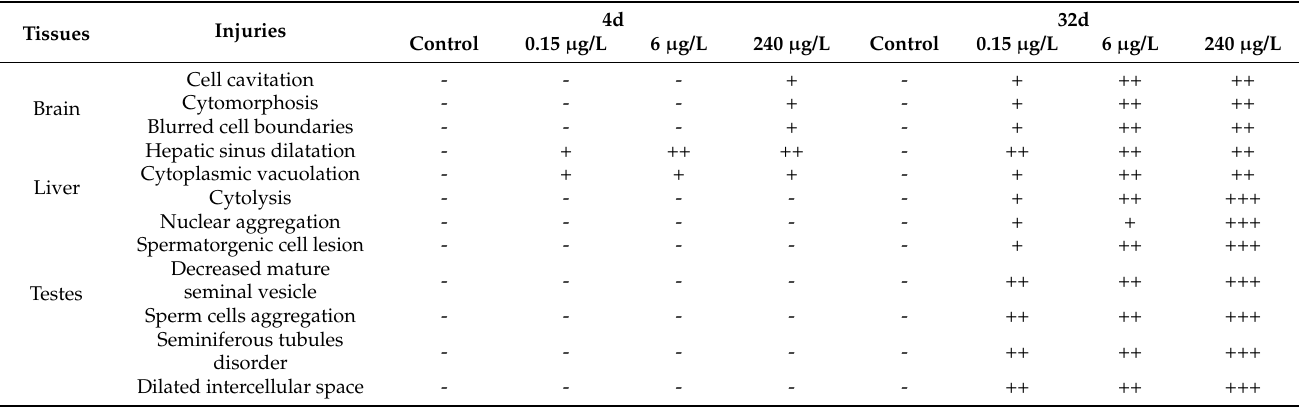
Table 1. Histopathological effects in the brain, liver and testes of male mosquitofish suffering from 0, 0.15, 6, 240 µ g/L PrP for 4d and